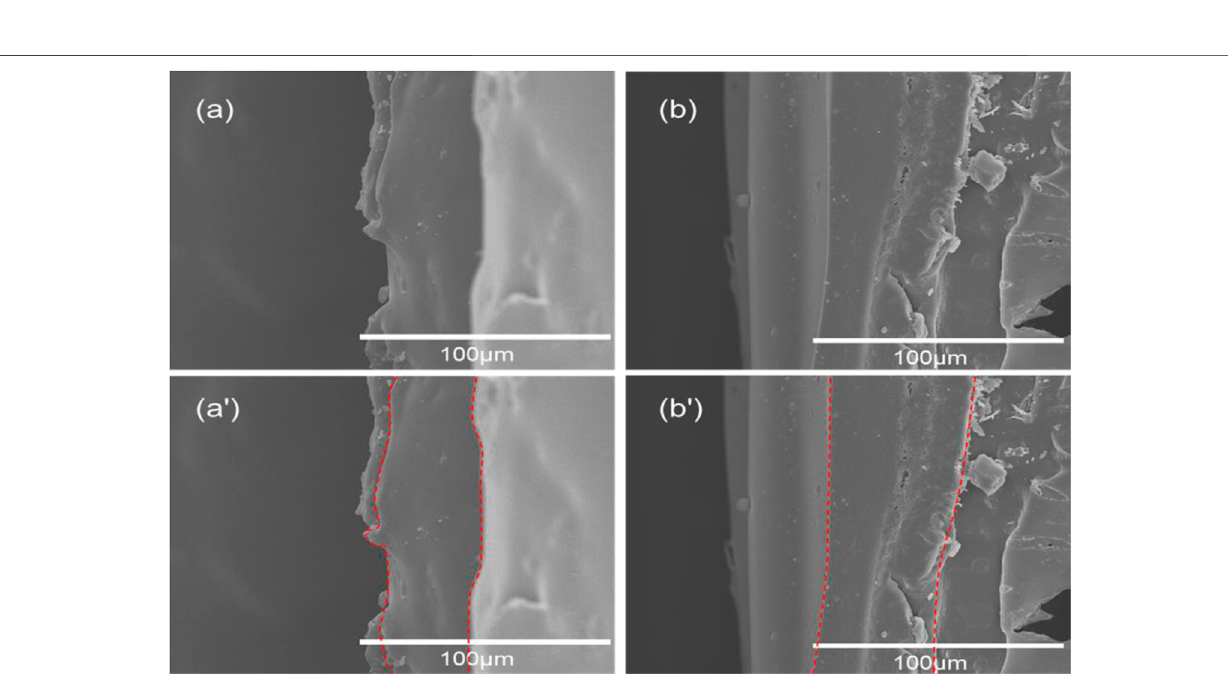
Frontiers in Materials |